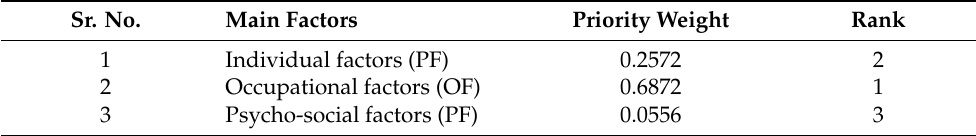
Table 12. Priority weight and ranking of main criteria. Sr.